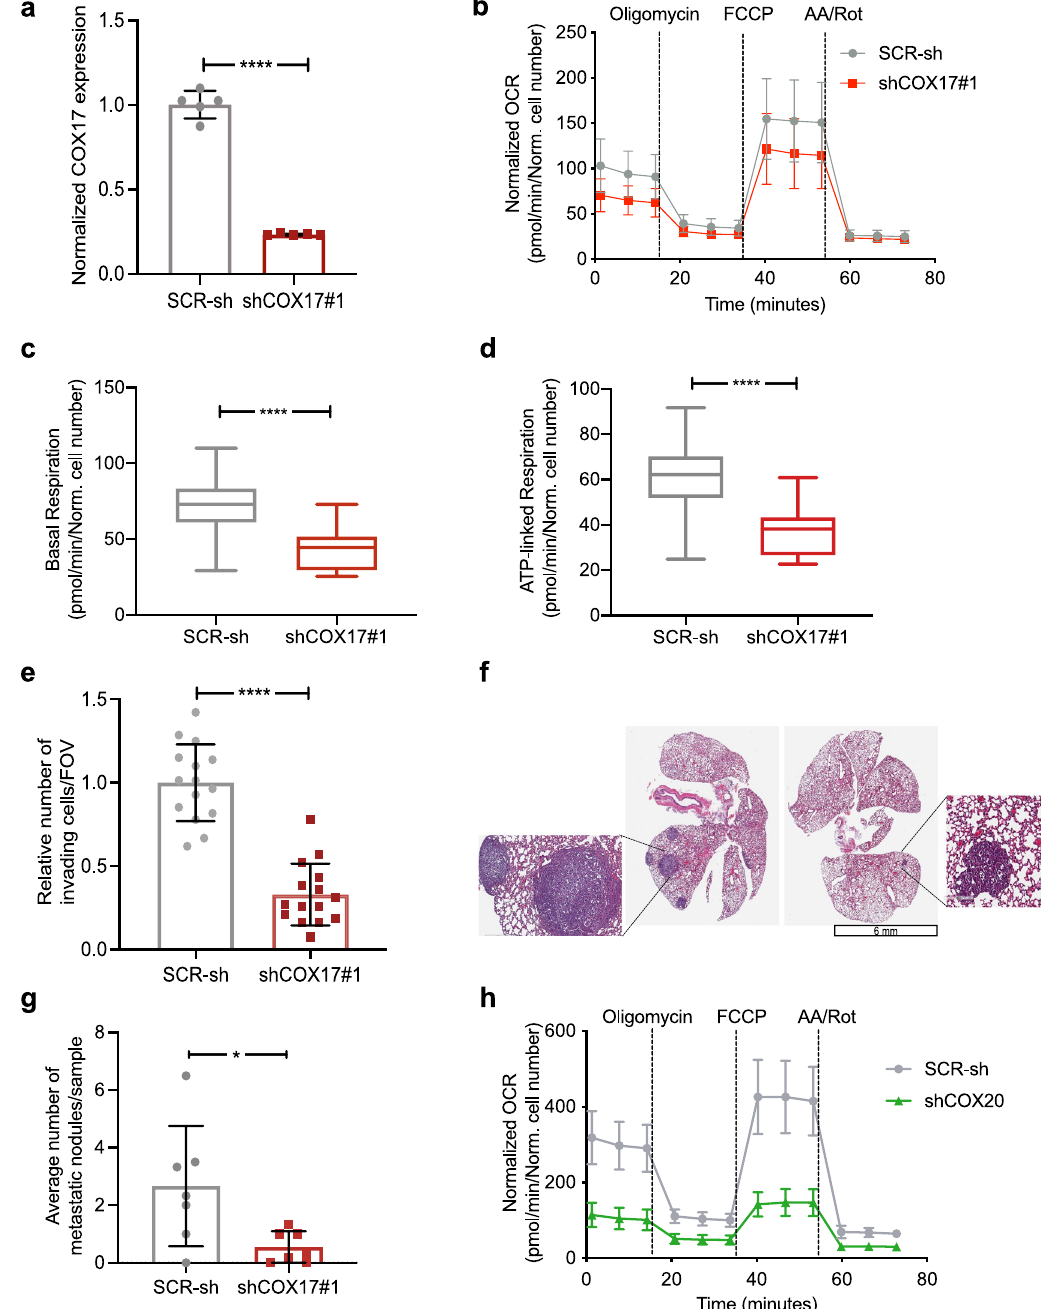
Fig. 5 COX17 knockdown yields TM phenotypes. a qPCR showing shRNA-mediated COX17 knockdown in LM2 cells. Analysis was performed by unpaired t -test ( n = 5/group). b Oxygen consumption in shCOX17#1 vs. SCR-sh ( n = 8 for SCR-sh, n = 6 for shCOX17#1). c , d Basal and ATP-linked respiration in shCOX17#1 vs. SCR-sh cells using mitostress assay. Analysis was performed by unpaired two-sided t -test. Center lines of box plots denote median values, top whiskers denote maxima and bottom whiskers minima. e Invasion assay through matrix-coated transwell. Analysis was performed by unpaired two- sided t -test ( n = 3/group, 5 fi elds of view/sample). f Representative images of metastatic nodules in lungs using shCOX17#1 and SCR-sh LM2 in vivo model ( n = 7/group). g Quanti fi cation of lung metastases from panel f . Analysis was performed by unpaired two-sided t -test. p -value = 0.0236. h Oxygen consumption rate in ML1 SCR-sh vs. shCOX20 cells ( n = 8/group). Representative data of two independent experiments are depicted. Results are expressed as mean ± SD. * p < 0.05, **** p <